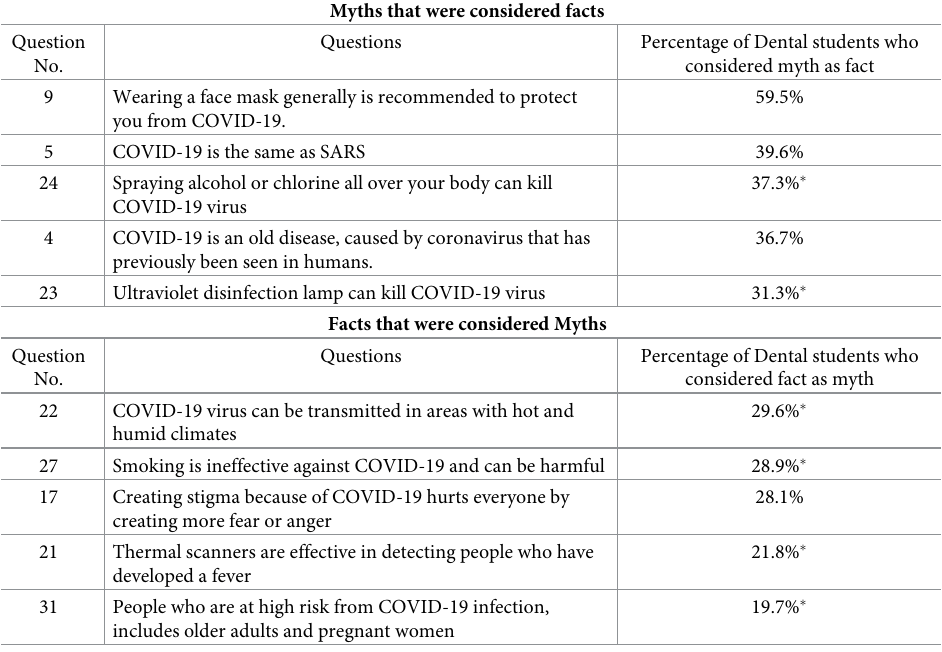
Table 3. Top five Myths that were considered facts and vice versa by dental students.